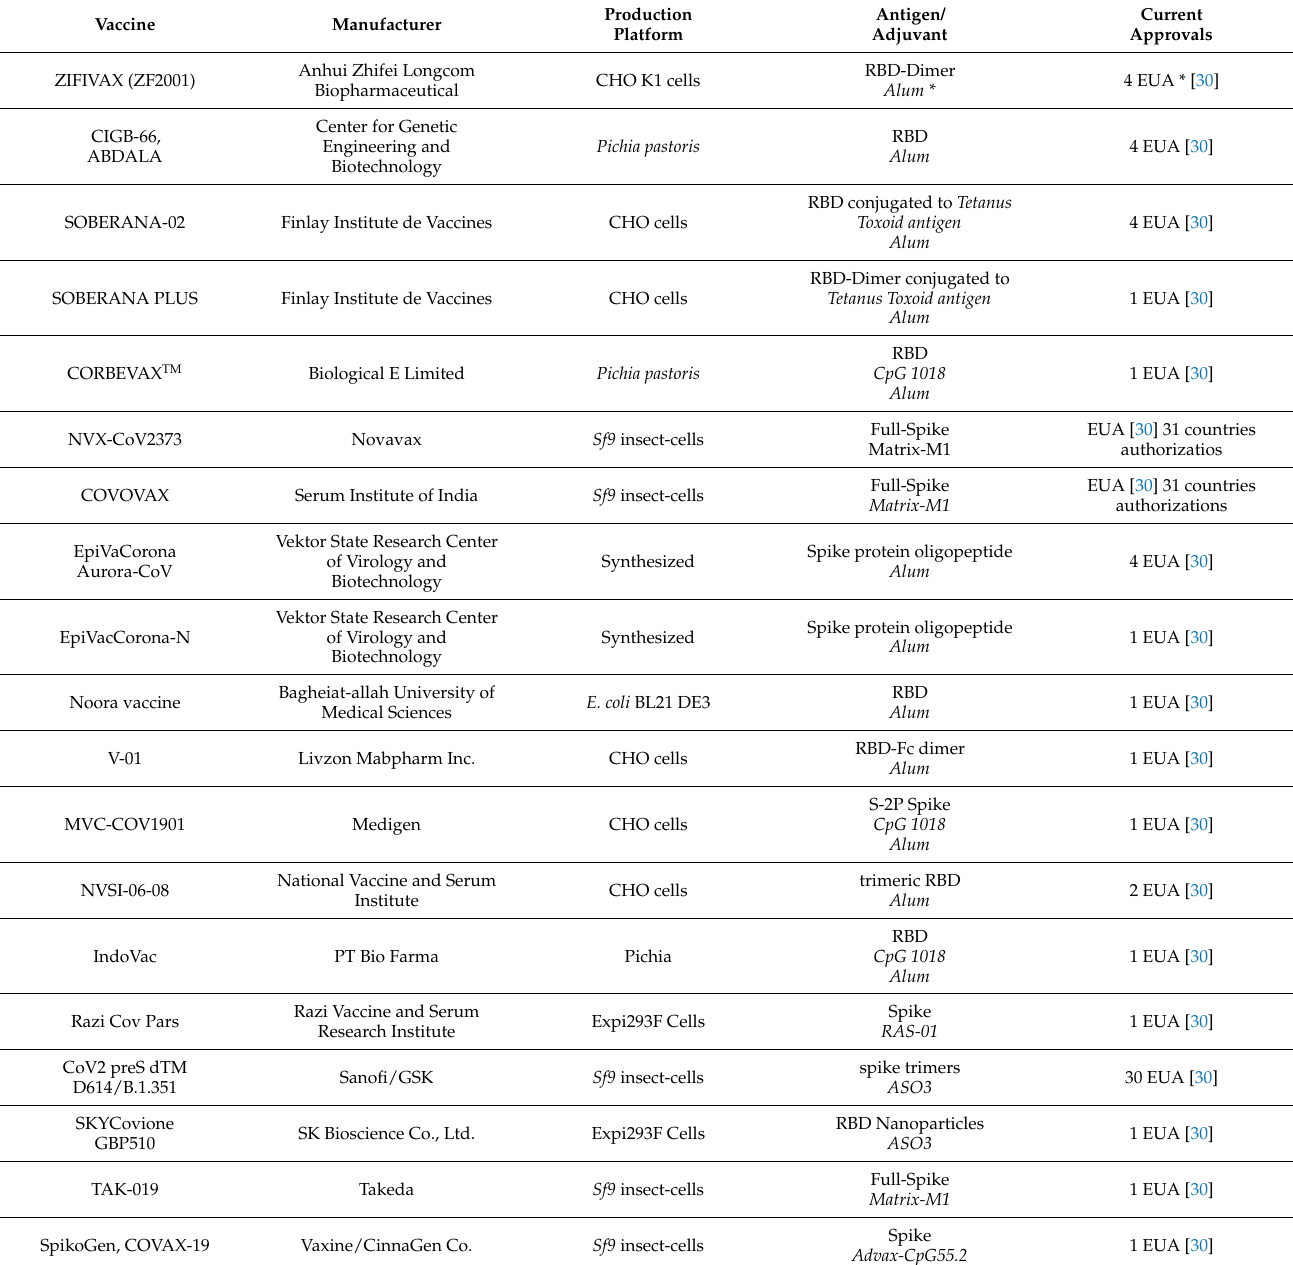
Table 1. Protein subunit SARS-CoV-2 vaccines authorized for